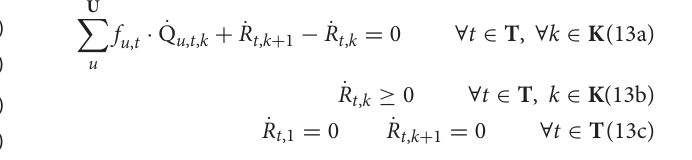
maximum boundaries set (f min (12e) fix the size of the process units ( pu